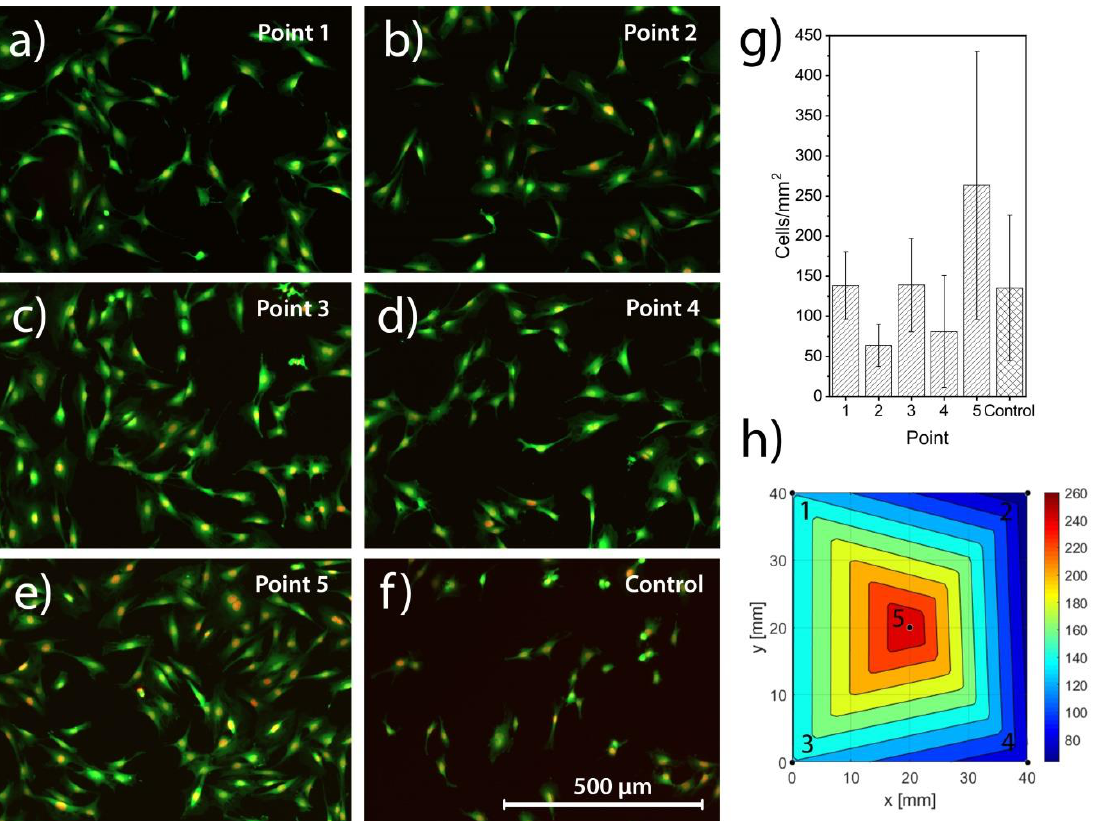
Figure 8. MC3T3 cells stained with Hoechst and CFDA-SE and imaged in a fluorescent microscope for point 1 in ( a ), point 2 in ( b ), point 3 in ( c ), point 4 in ( d ), point 5 in ( e ) and the tissue culture plastic control in ( f ). The quantified number of cells/mm 2 , shown in ( g ), displays high standard deviations and no significant differences, neither between points nor to the control. To better visualize the results the cell density is presented as a color plot, ( h ).